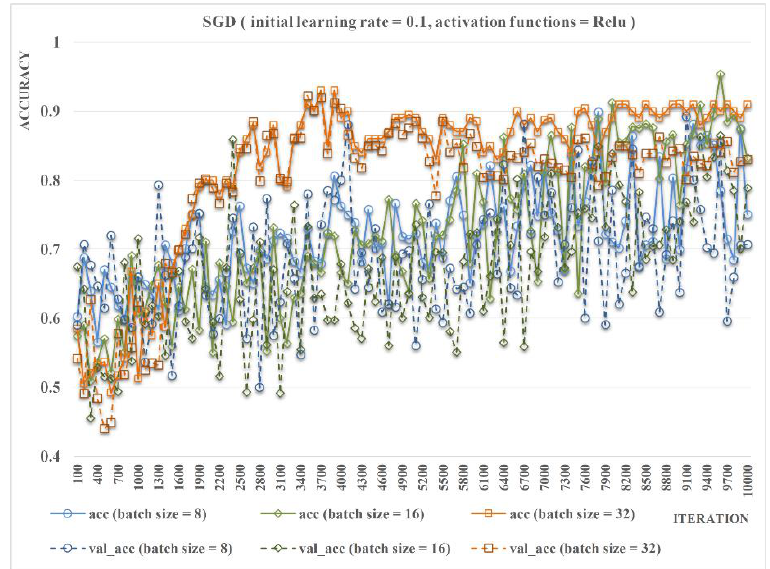
Figure 7. Comparison of the accuracy of ResNet-Locust-BN based on different batch sizes (activation function = ReLU, initial learning rate = 0.1).